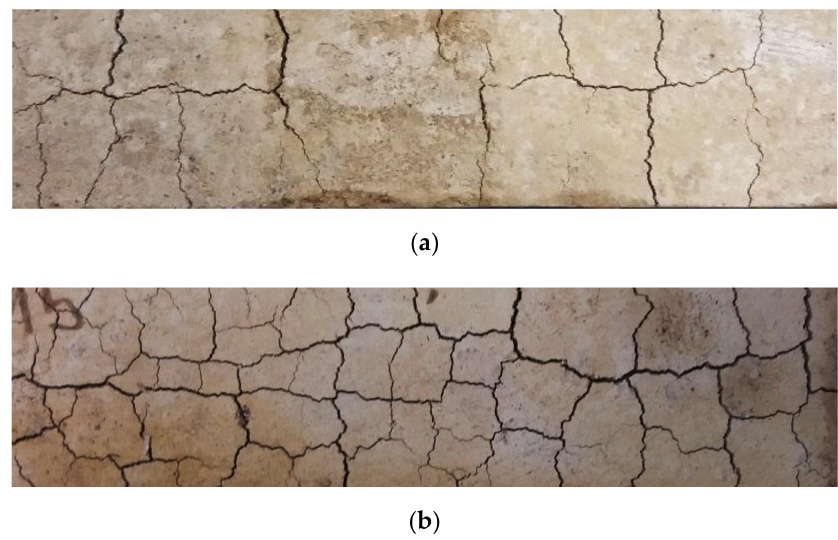
Figure 14. The surface appearance of samples cured in different conditions for WBA2: ( a ) 95% relative humidity (RH), ( b ) 65% relative humidity (RH).